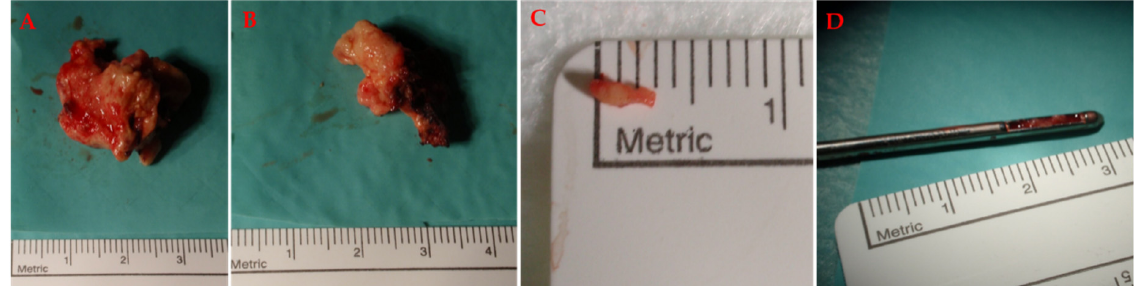
Figure 2. Various resection specimens obtained during brain surgeries. ( A ) In open surgery and in gross resections, abundant tissue is obtained that can be used for further processing in the cell laboratory, as in open glioblastoma surgery. ( B ) The resection specimen of glioma obtained from open biopsy or smaller keyhole approach. ( C ) The glioma sample from the needle biopsy. ( D ) The biopsy needle with the tissue sample. The images were taken during routine neurosurgical procedures and the tissue was also collected for the purpose of cell culture isolation. The ethical approval number was KME RS 0120-565/2020/5.